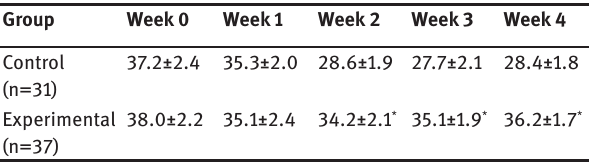
Table 2: Comparison of serum albumin levels at different time points.